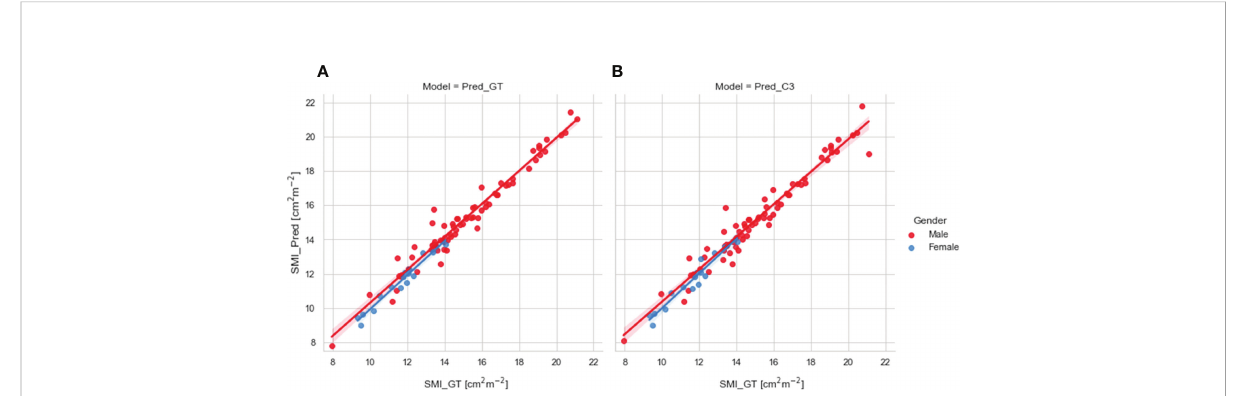
FIGURE 4 Scatter plots of the skeletal muscle index (SMI) values determined for test set patients (strati fi ed by gender) using the ground-truth manual segmentation (x-axis) and those determined using predicted segmentations of the 2D ResUNet (y-axis) using (A) the ground-truth CT image slice (Pred_GT) and (B) the auto-selected CT image slice using the C3 section auto-segmentation